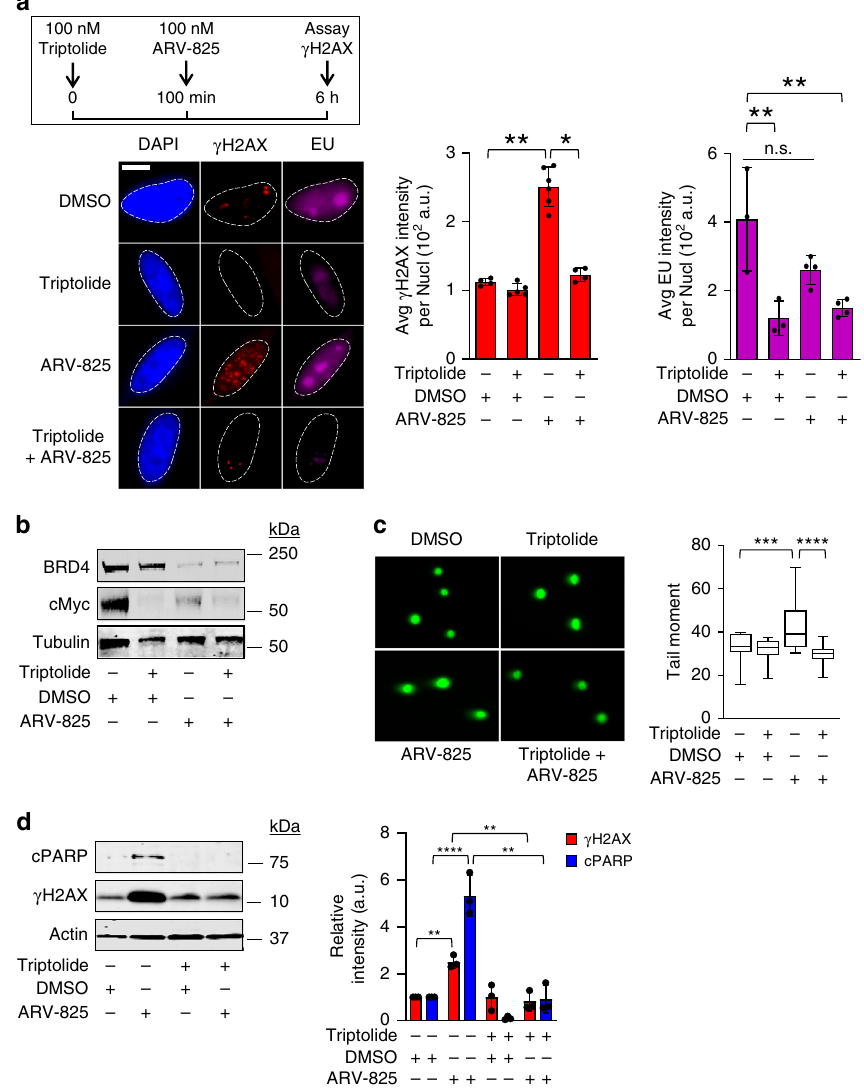
Fig. 2 DNA damage caused by BRD4 degradation requires active transcription. a Top right: schematic of triptolide/ARV-825 co-treatment experiment in HeLa cells. Bottom right: representative IF images of HeLa cells following treatment with triptolide and/or ARV-825. EU incorporation was used to assess RNA synthesis. Left: Quanti fi cation of integrated γ H2AX and EU intensity per nucleus quanti fi ed from >300 cells as in Fig. 1a ( n = 3). Signi fi cance assessed using ANOVA followed by Tukey ’ s test ( γ H2AX DMSO vs ARV-825 **Adjusted P = 0.0038; γ H2AX Triptolide vs Triptolide + ARV *Adjusted P = 0.0139; EU DMSO vs Triptolide **Adjusted P = 0.0041; EU DMSO vs Triptolide + ARV-825 **Adjusted P = 0.0055). Scale bar = 2.5 μ m. b Lysates of cells treated with triptolide and/or ARV-825 were analyzed for BRD4 and cMyc levels by WB. c Representative fl uorescence microscopy images of neutral comet single cell gel electrophoresis assay after triptolide and/or ARV-825 treatment. Box-whisker plots drawn as in Fig. 1b ( n = 3). Signi fi cance assessed using ANOVA followed by Tukey ’ s test, ***Adjusted P = 0.0002, ****Adjusted P < 0.0001. d Lysates from cells pretreated with triptolide followed by co-treatment with ARV-825 were analyzed for γ H2AX and cPARP by WB. Relative intensity of bands was quanti fi ed ( n = 3). Signi fi cance assessed using ANOVA followed by Tukey ’ s test ( γ H2AX DMSO vs ARV-825 **Adjusted P = 0.0051; γ H2AX ARV-825 vs Triptolide + ARV-825 **Adjusted P = 0.0019; cPARP DMSO vs ARV-825 ****Adjusted P < 0.0001;